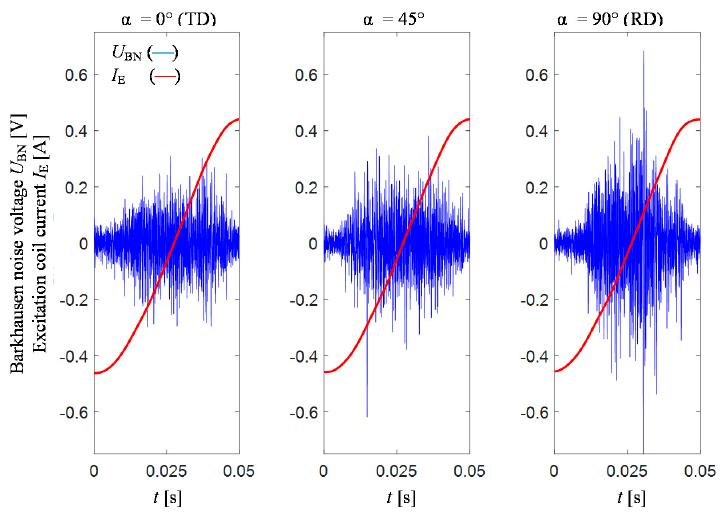
Figure 3. Exemplary distributions of MBN voltage U BN and magnetizing current I E acquired for excitation frequency of 10 Hz and voltage amplitude of 0.275 V.